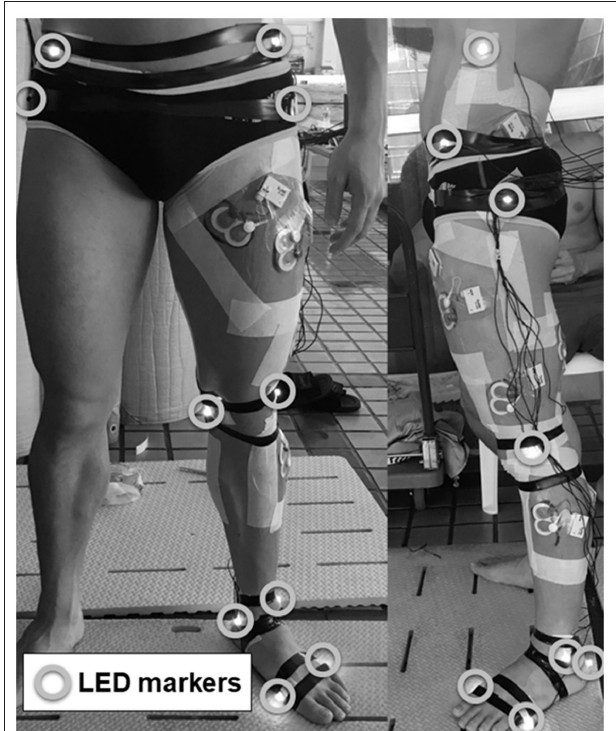
FIGURE 1 | Images of a swimmer’s left lower limb with active LED markers attached to 13 anatomical landmarks and surface EMG devices attached to eight muscles. Left: front view; right: lateral view.